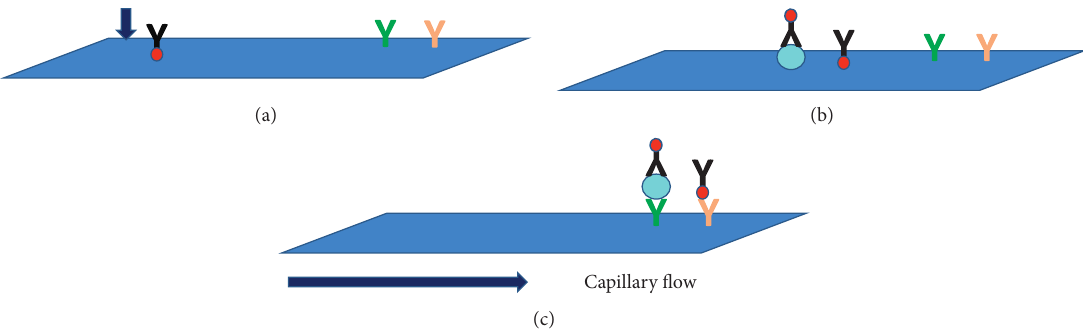
Figure 1: General principle of an LFT immunoassay. (a) Sample with an analyte (circle) is added to the pad where a labeled antibody (Y shaped) already exists. (b) Analyte and a labeled antibody are carried by a lateral flow (arrow) and they can mutually interact. (c) Complex of analyte-labeled antibody and the labeled antibody are captured on test spot (analyte) or control spot (unreacted antibody) forming colored lines.